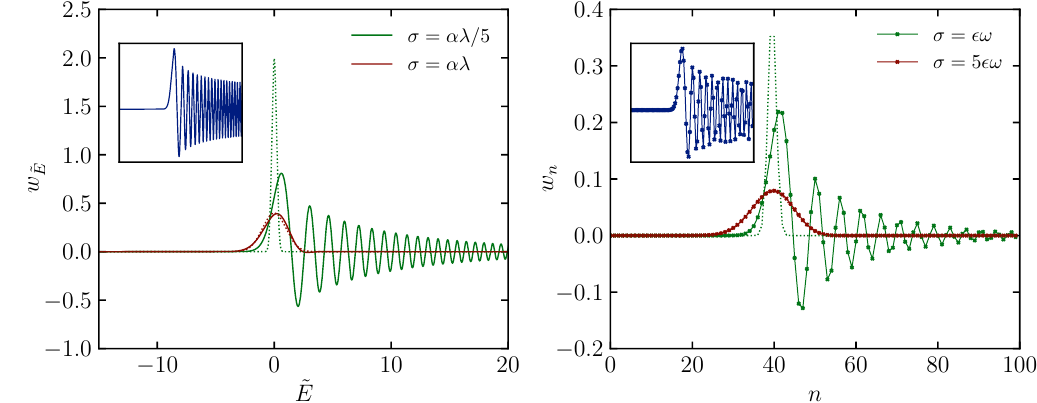
Figure 12: The eigenvalues of a microcanonical distribution with Gaussian un- certainty on the classical energy reproduces the original distribution for suffi- cient width. Left: linear potential, full line is averaged w ˜ , dashed line is ρ ( ˜ E ) as E = E = 0 and αλ = 1. Right: harmonic a Gaussian with width σ centered on E avg potential, full line is averaged w , dashed line is ρ (( n + 1 / 2 ) εω ) εω , with εω = 1 n = 4. In both figures the inset and the Gaussian with width σ centered on E = E avg details the eigenvalues without any uncertainty, where a connecting line is added to the right (discrete) eigenvalues to guide the